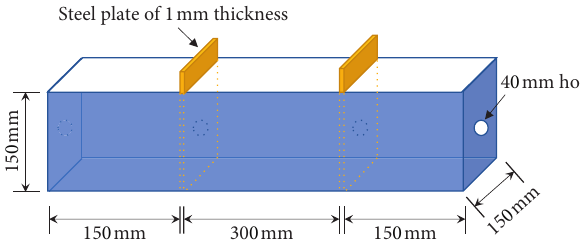
Figure 11: Wooden mold for casting concrete blocks.